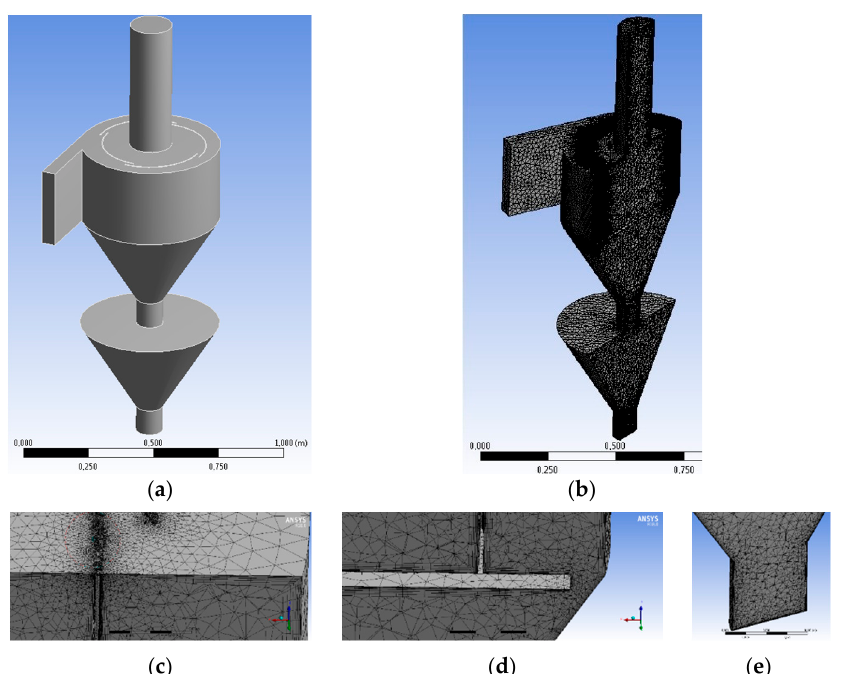
Figure 2. The computational mesh of a single inlet multi-channel cyclone separator: ( a ) general geometry view, ( b ) mesh with a partial section through the cyclone-separator axis, ( c ) wall layer by the cover of the separation chamber, ( d ) joint wall layer of the separation chamber bottom and a curved element, ( e ) cylindrical part of the bottom of the hopper.